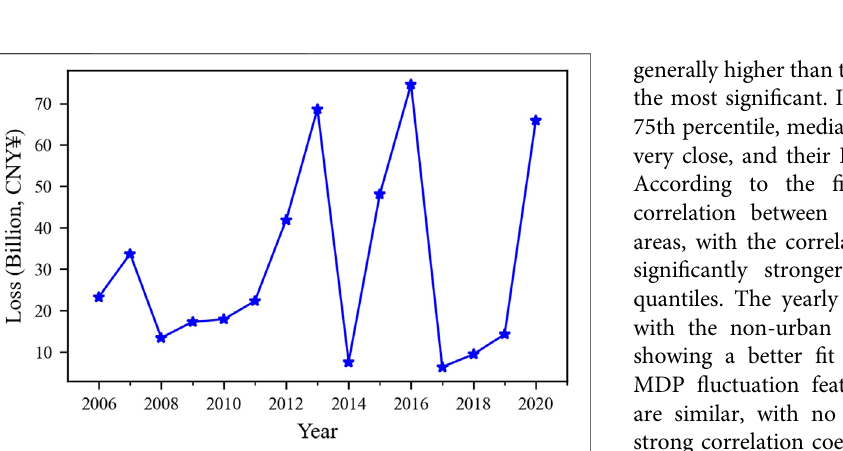
FIGURE 8 | Historical fl ood loss in Jiang-Zhe-Hu-Wan region. Jiang, Zhe, Hu, and Wan are the abbreviations of Jiangsu Province, Zhejiang Province, Shanghai City, and Anhui province, respectively.